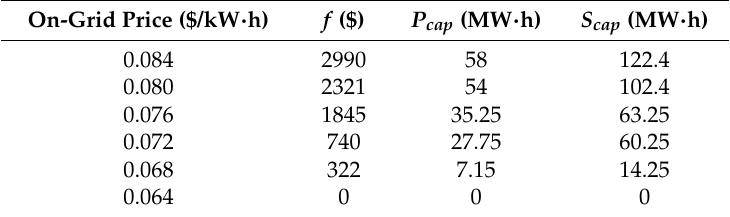
Table 5. Optimal results under different on-grid prices of wind